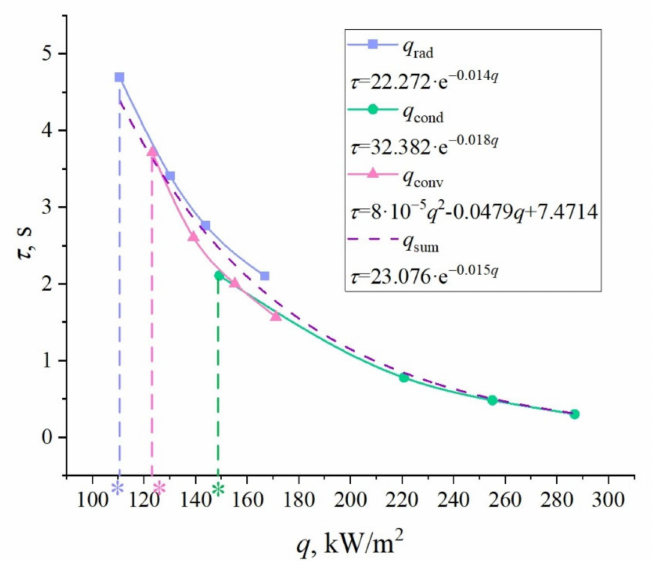
Figure 10. Heat flux densities during radiant, convective and conductive ignition of the gel fuel ( T f = 203 K) at heating temperatures in the range of 973–1273 K; approximation expressions for the ignition delay times (* is the critical heat flux density at which the gel fuel is ignited through different heating